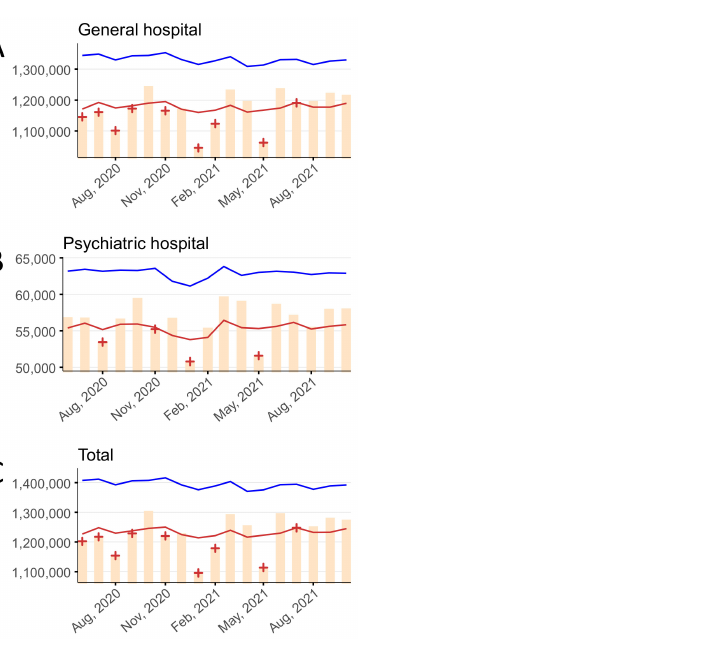
Figure 1. The monthly average number of outpatients per day stratified by hospital type, low bars indicate the observed number of outpatients per day. Blue and red lines show the upper and lower limits, respectively, of the 95% prediction interval. Red + symbols indicate statistically sig- nificant monthly deficits. Gray shading corresponds to the state of emergency declarations in